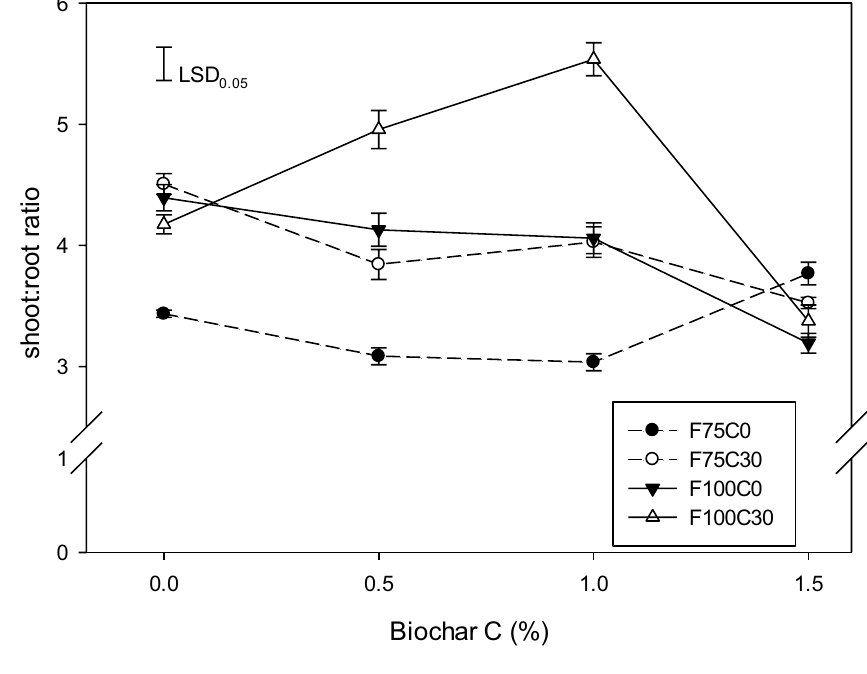
Fig. 4 The interactive effect of fertiliser rates (75 and 100%) and biochar rates (0, 0.5, 1.0 and 1.5% biochar C) in media without and with compost treatment (0 and 30% v/v compost) on shoot:root ratio (mean ± standard error) of oil palm seedling, ( n = 4). Note: F75C0 75% fertiliser recom- mended rate in soil without compost; F75C30 75% fertiliser recommended rate in soil with 30% v/v compost; F100C0 100% fertiliser recommended rate in soil without compost; F100C30 100% fertiliser recom- mended rate in soil with 30% v/v